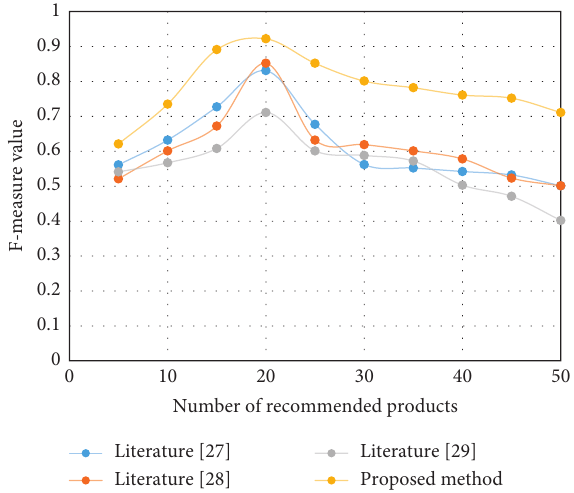
Figure 9: The F-measure value of this algorithm and other algorithms.